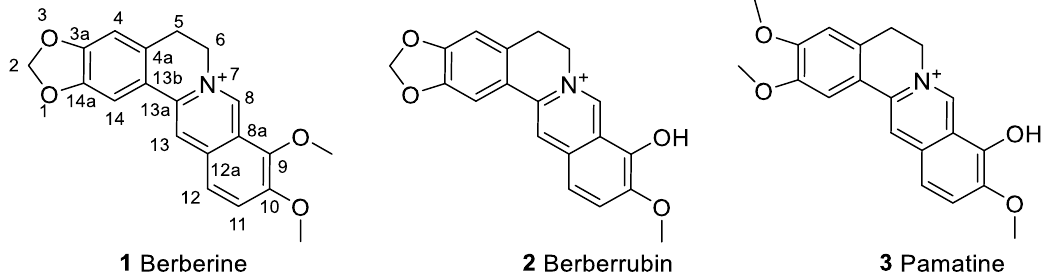
Figure 1. The structure of berberine and its natural derivatives, berberrubine and palmatine.